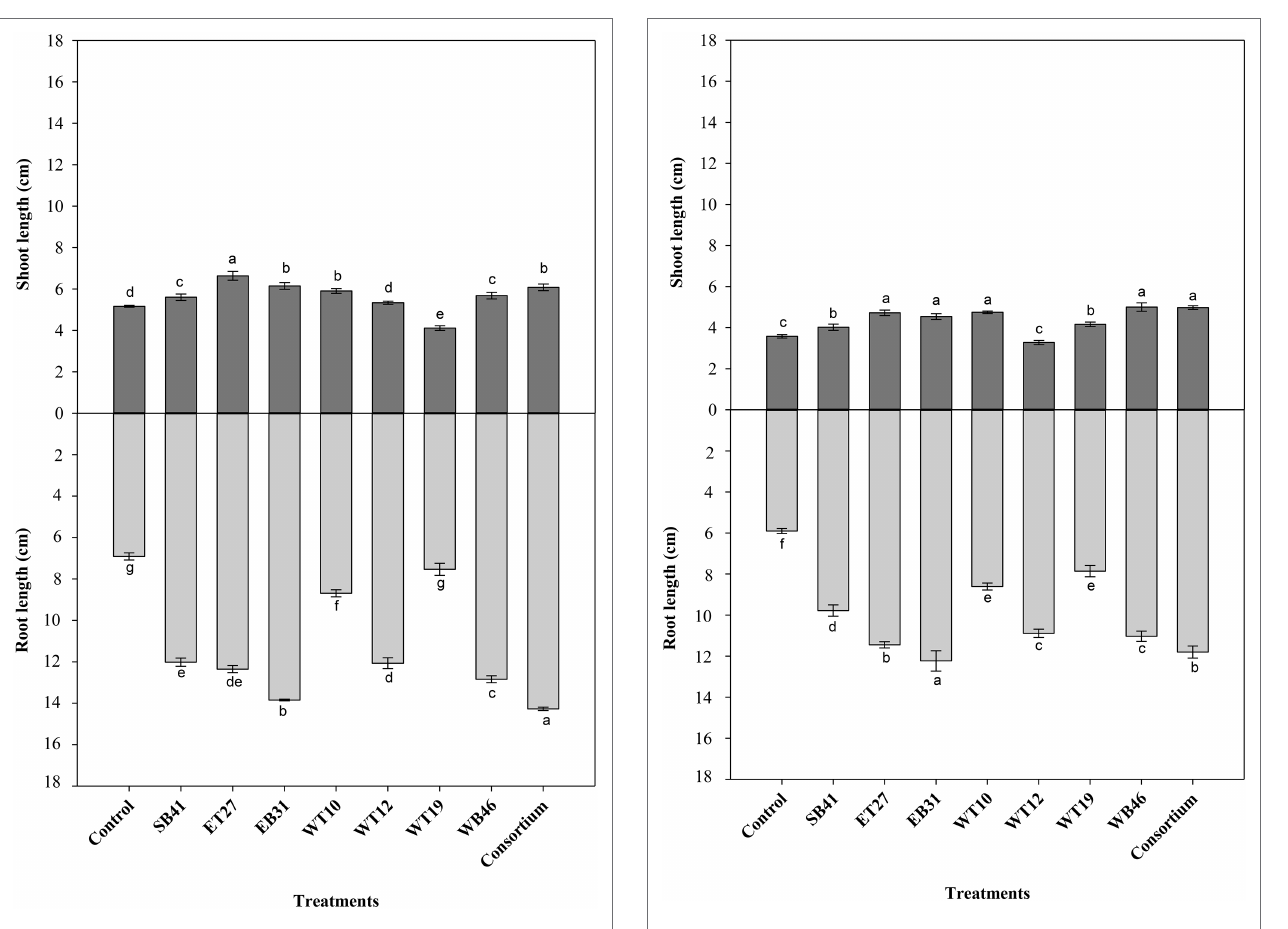
FIGURE 4 | Effect of selected PGPR bacterial strains on root and shoot length (cm) of canola plants measured after 7 days of growth in the presence of 1% n -hexadecane. Error bars represent SDs, and different letters indicate significance according to Tukey’s post-hoc test at p ≤ 0.05.